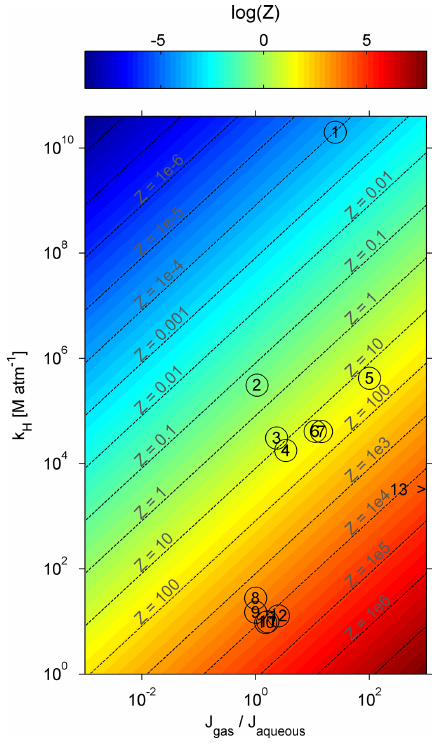
Fig. 3. Best estimate for the maximum ratio of gas phase photoly- sis to aqueous phase photolysis, Z , for a series of carbonyls in an air parcel with a LWC = 0.5gm − 3 at 298K. The “ > ” label next to species 13 (formaldehyde) indicates that it lies at Z (cid:29) 10 4 where J aqueous ∼ 0. Species are labeled in order of increasing Z : (1) glyc- eraldehyde, (2) pyruvic acid, (3) gluteraldheyde, (4) methyl gly- oxal, (5) glyoxal, (6) glycolaldehyde, (7) glyoxylic acid, (8) ace- tone, (9) butanone, (10) butanal, (11) propanal, (12) acetaldehyde, and (13)